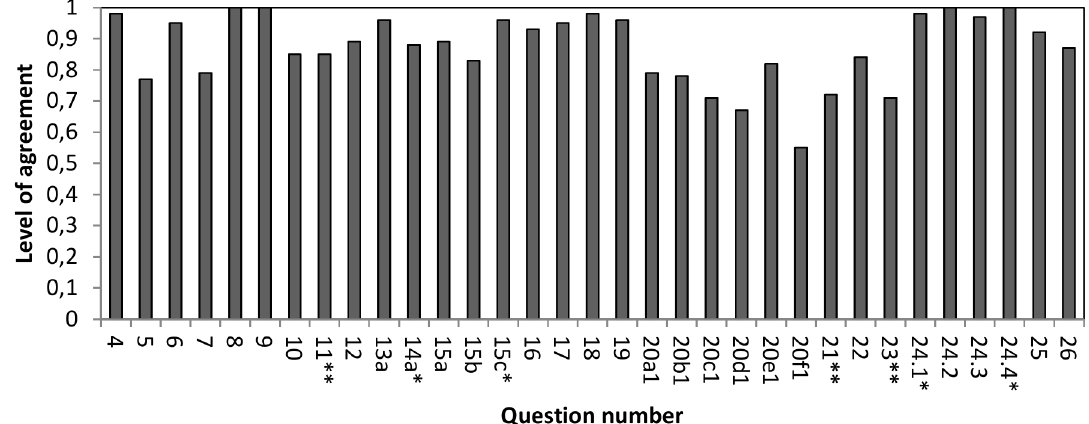
Fig 1. Level of agreementfor 33 ELQ items. * Items used to calculatequalityindicators. ** Items used to calculatequality indicators under development.